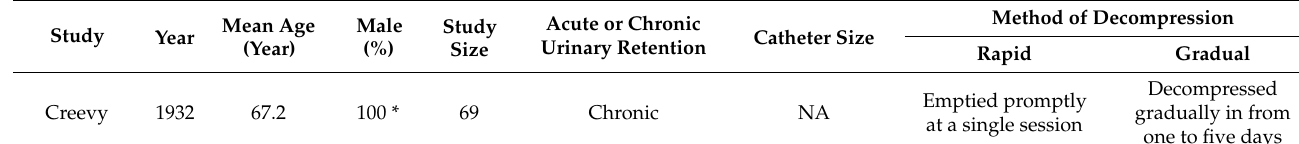
Table 2. Characteristics of included studies.